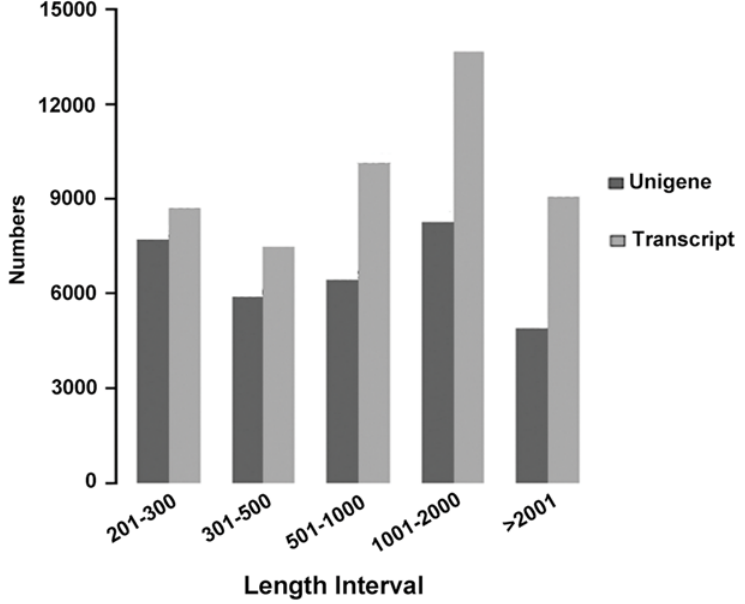
Fig 2. Length frequency distribution of transcripts and unigenes assembled by Trinity. X-axis represents the size of sequences (nt), and Y-axis indicates the number of sequences.